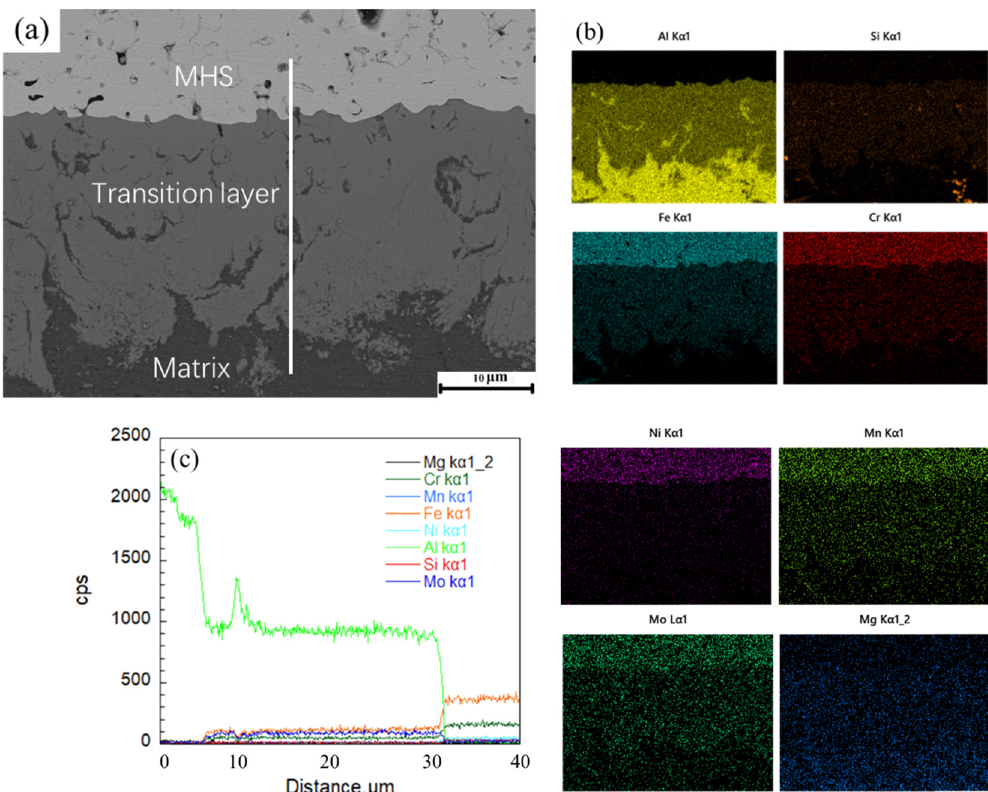
Figure 4: The distribution of alloying elements between the MHS and the matrix, and the results of line scan: ( a ) the transition layer between MHS and matrix; ( b ) the distribution of alloy elements around transition layer; and ( c ) the EDS results at the white line in ( a )